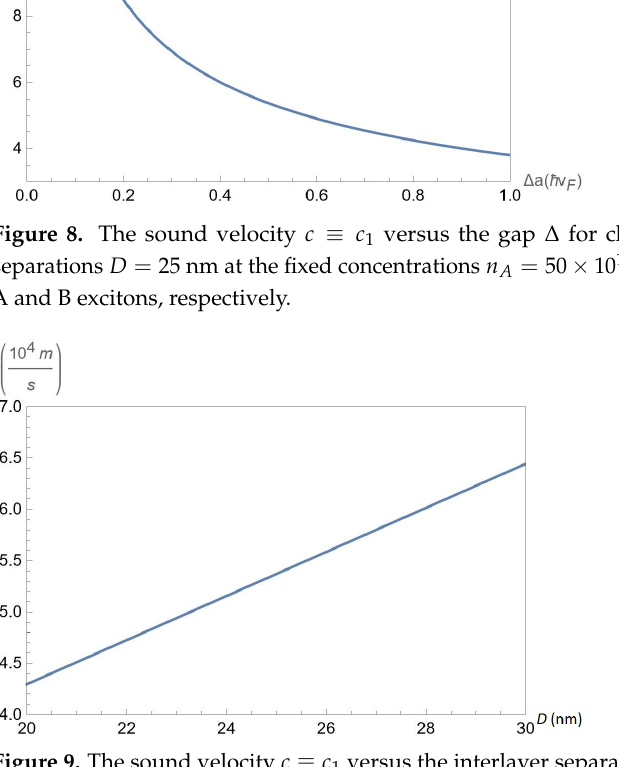
Figure 9. The sound velocity c ≡ c 1 versus the interlayer separation D for chosen parameter α = 0.6 and gap ∆ = 0.5 ¯ hv F / a , at fixed concentrations n A = 50 × 10 11 cm − 2 and n B = 50 × 10 11 cm − 2 of A and B excitons, respectively.